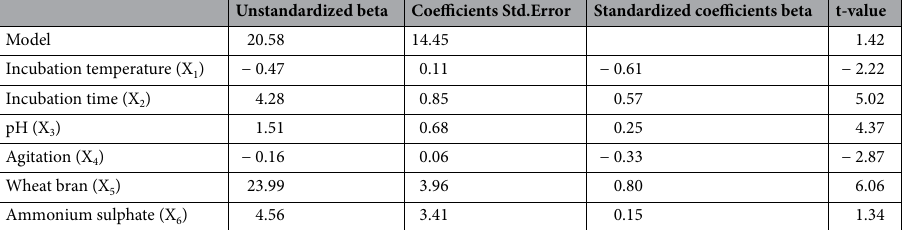
Table 6. Effect estimates for xylanase production from the results of